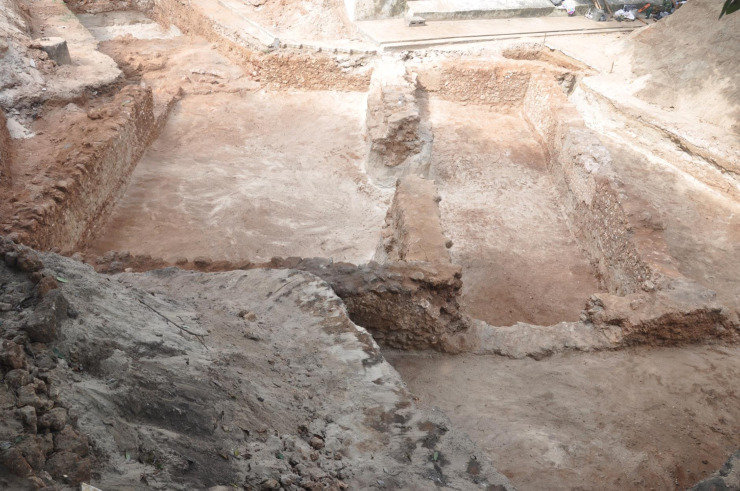
Excavated area of CA in Malindi, Kenya.Photo of the excavated Area CA in Malindi. Remains of the house foundations were found in Area CA, where all of the glass vessels were found.